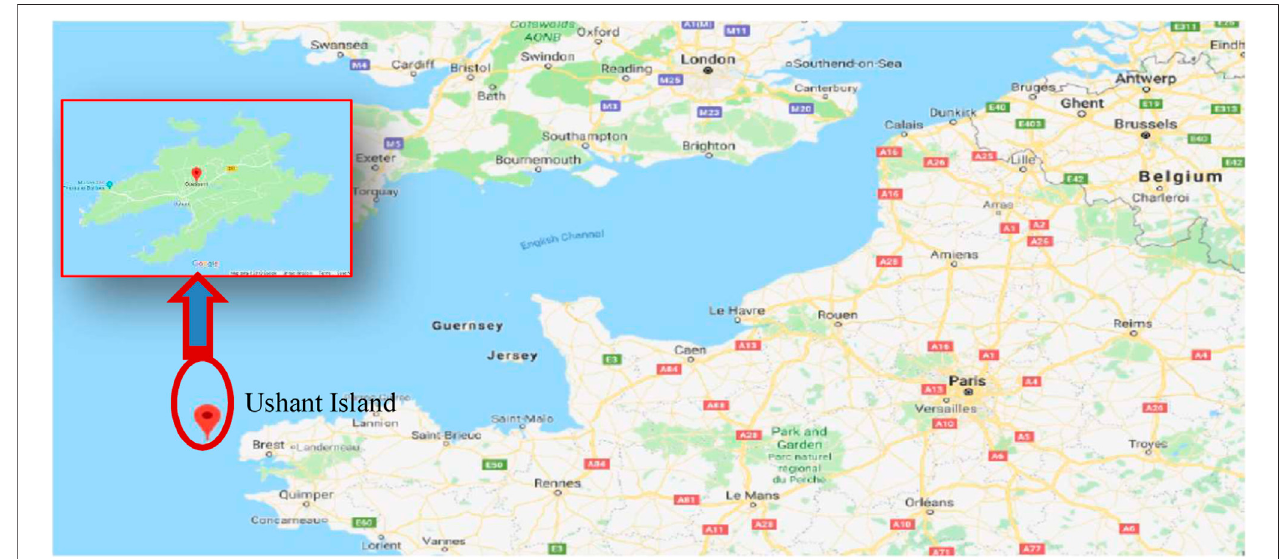
FIGURE 3 | Map showing the location of Ushant [Google